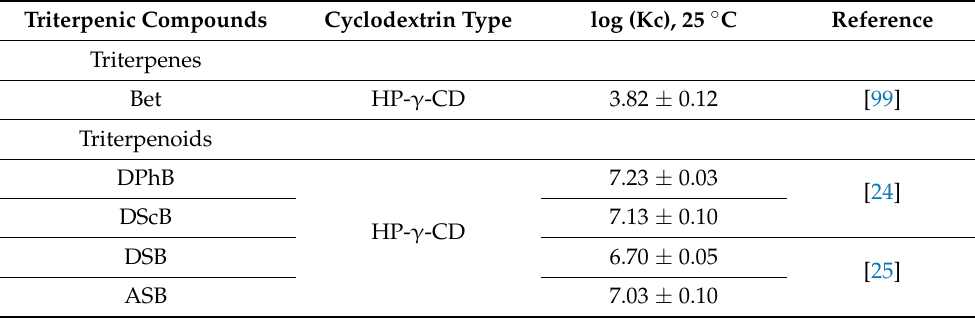
Figure 3. An overview of the methods used to characterize inclusion complexes in solid and liq- uid state (differential scanning calorimetry (DSC), thermogravimetric analysis (TGA), hot-stage microscopy (HSM), single-crystal X-ray diffraction (SCXRD), powder X-ray diffraction (PXRD), Fourier-transform infrared (FT-IR) spectroscopy, attenuated total reflectance (ATR)-FTIR spectroscopy, nuclear magnetic resonance (NMR) and electron spin resonance (ESR)). Table 5. Kc values of inclusion complexes between HP- γ -CD and Bet